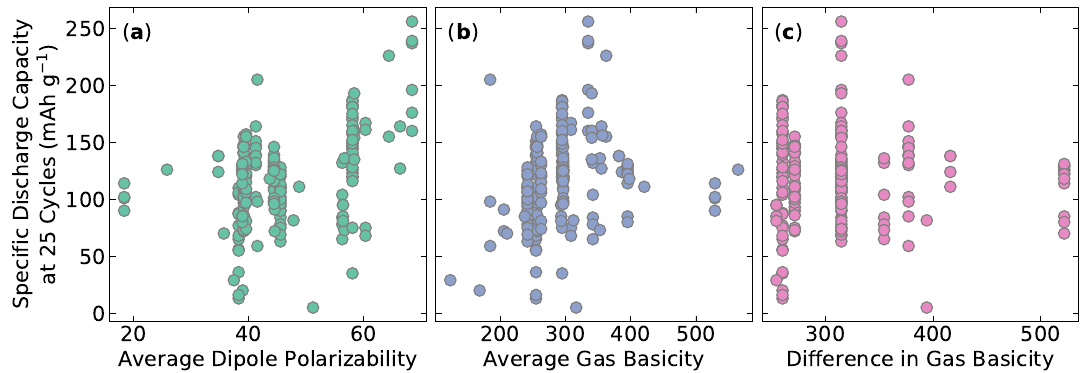
Figure 1. Specific discharge capacity at 25 cycle (mAh g − 1 ) versus the following descriptors: ( a ) mean of the dipole polarizability; ( b ) atomic volume maximum difference; and ( c ) the mean of the gas phase